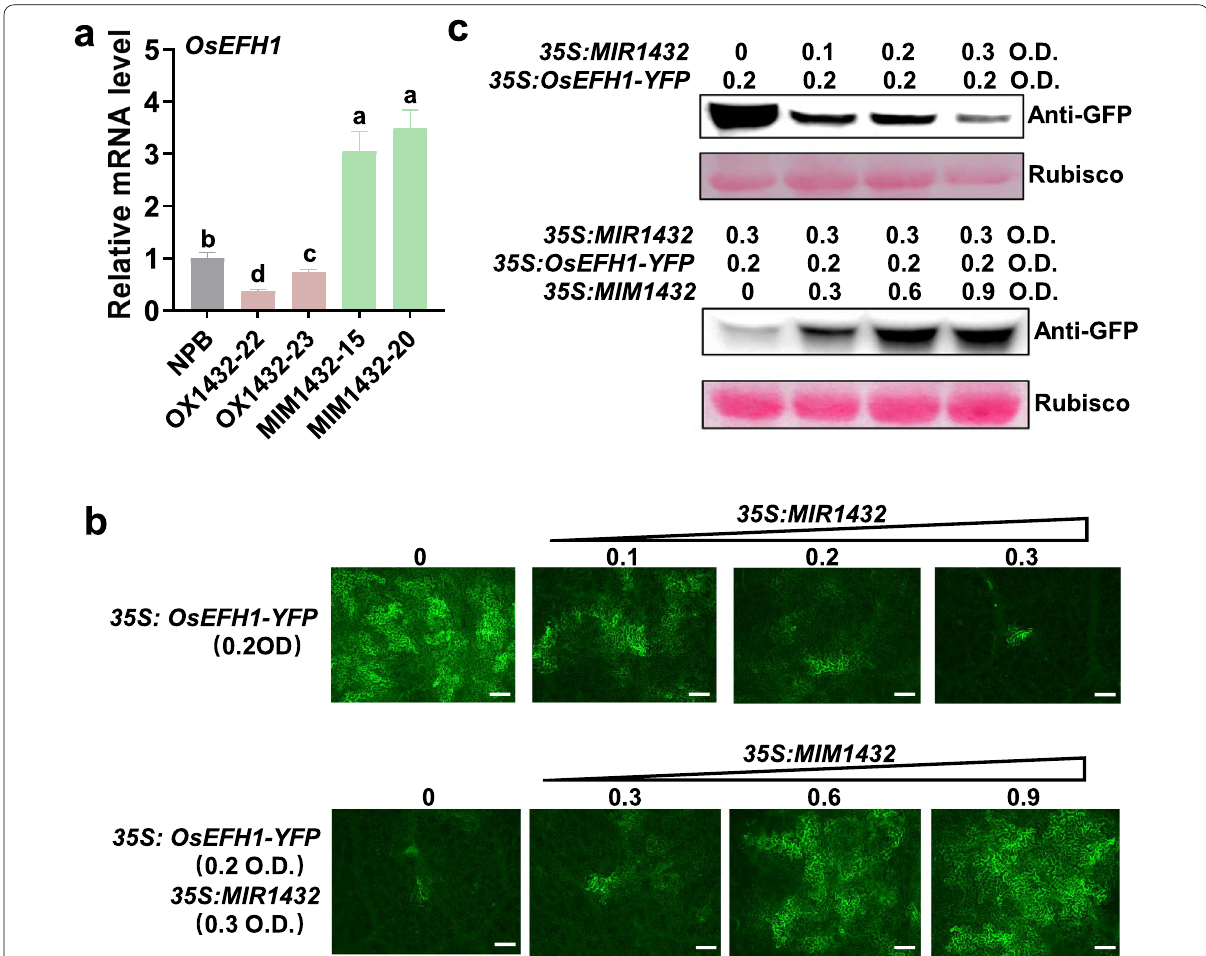
Fig. 3 miR1432 suppresses the expression of OsEFH1 . a The relative mRNA levels of OsEFH1 in OX1432, MIM1432, and the Nipponbare (NPB) control. Error bars indicate SD (n 3 independent samples). Different letters above the bars indicate significant differences ( P < 0.01) as determined by = One‑way Tukey–Kramer analysis. b The YFP intensity of OsEFH1‑YFP fused protein in Nicotiana benthamiana leaves. The OsEFH1-YFP constructs were transiently expressed alone or co‑expressed with miR1432 alone or co‑expressed with miR1432 and MIM1432 together in Nicotiana benthamiana leaves using Agrobacterium‑mediated infiltration at the indicated concentration (Optical Density (O. D.)). Bar 100 μm. c Western blotting assay = indicates the protein levels of OsEFH1‑YFP in (B). All the experiments were repeated two times with similar